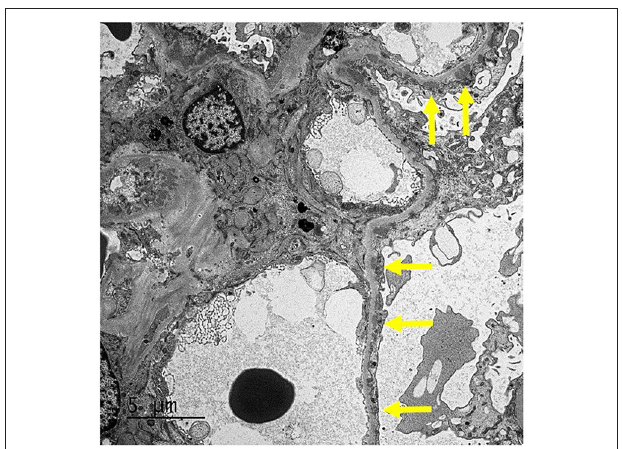
FIGURE 5 | EM: The glomerulus demonstrates mesangial and segmental small subepithelial electron-dense deposit (arrows).